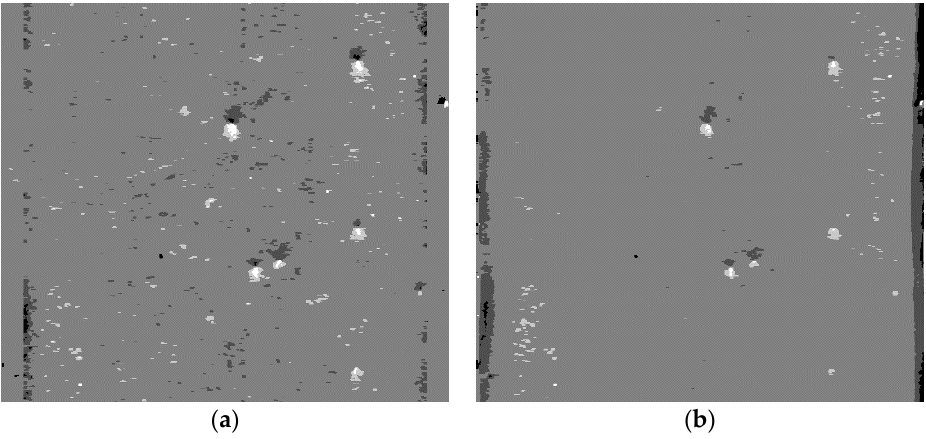
Figure 10. Results of noise reduction. ( a ) Result of partition noise reduction; ( b ) Result of traditional noise reduction without partition processing.